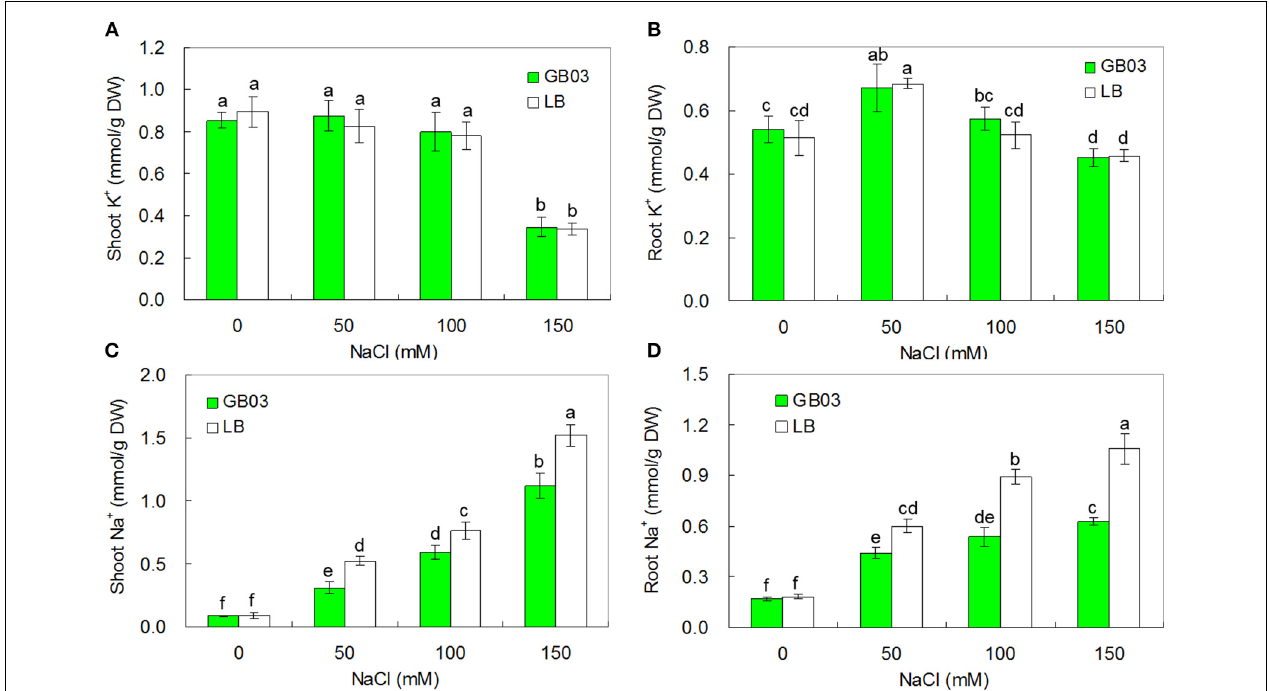
FIGURE 7 | Effects of GB03 bacterization on ion contents of white clover under various concentrations of NaCl. (A) shoot K + content, (B) root K + content, (C) shoot Na + content, (D) root Na +